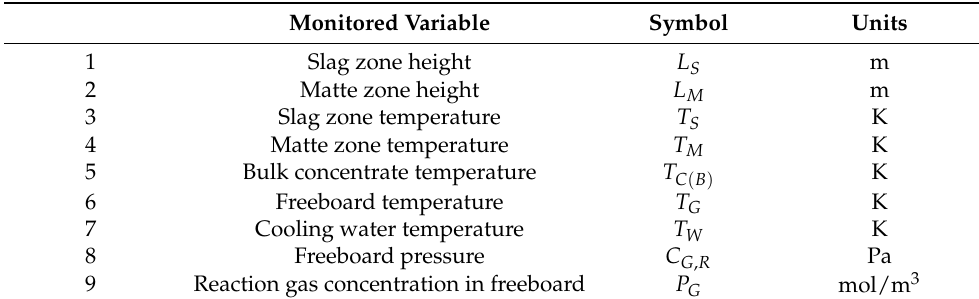
Table 1. Monitored variables in the simulated dataset.